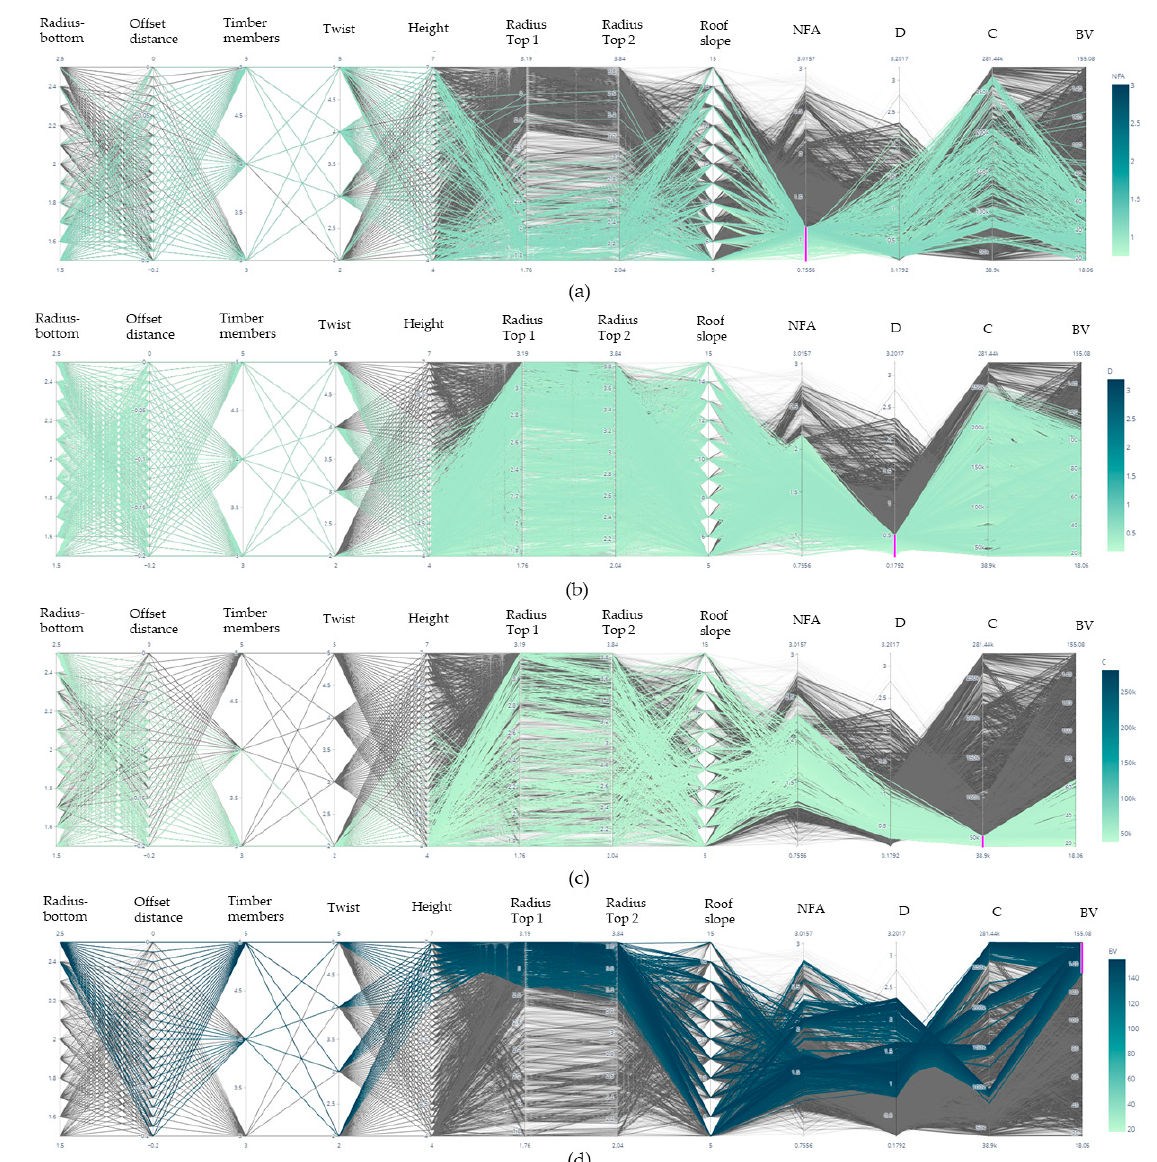
Figure 19. Parallel coordinate plots for structural optimization: ( a ) relation to lowest NFA; ( b ) relation to lowest D; ( c ) relation to lowest C; (d) relation to highest BV.